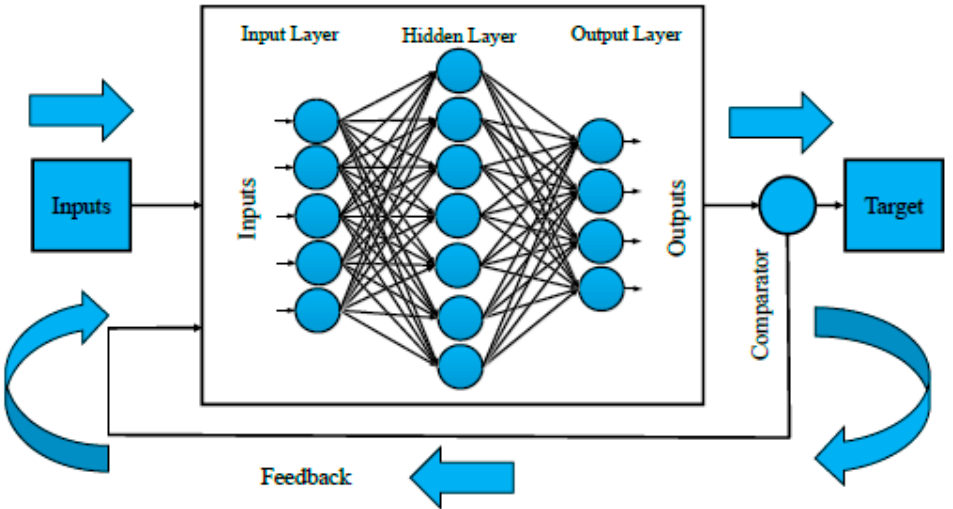
Figure 5. The structure of the nonlinear autoregressive (NAR) network.